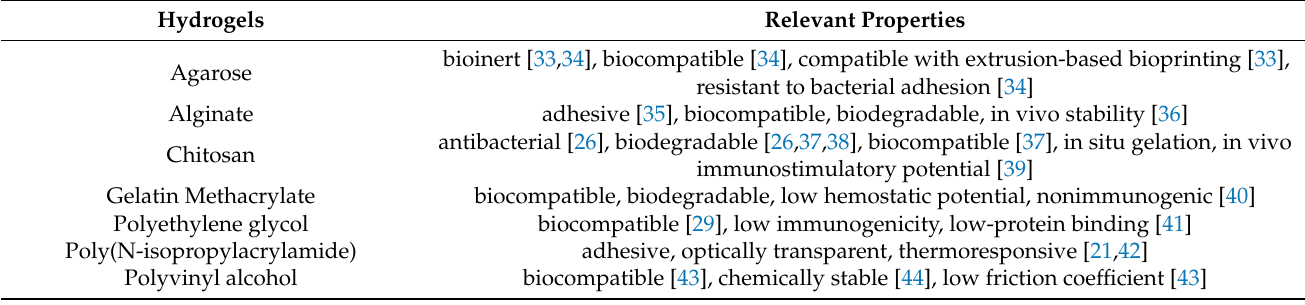
Table 1. Representative examples of hydrogels used in the biomedical industry and their properties. Hydrogels